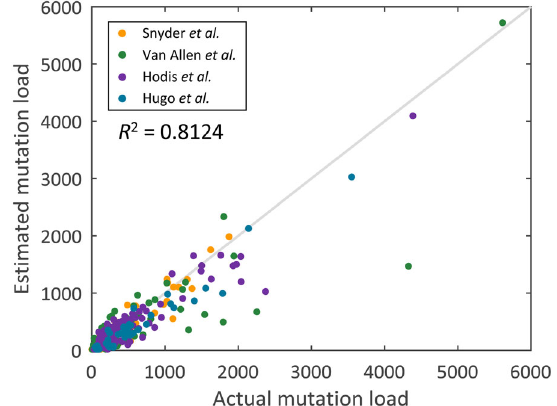
Fig. 4 Performance evaluation comparing the actual mutation load with the estimated mutation load using the melanoma model in an independent validation cohort ( n =